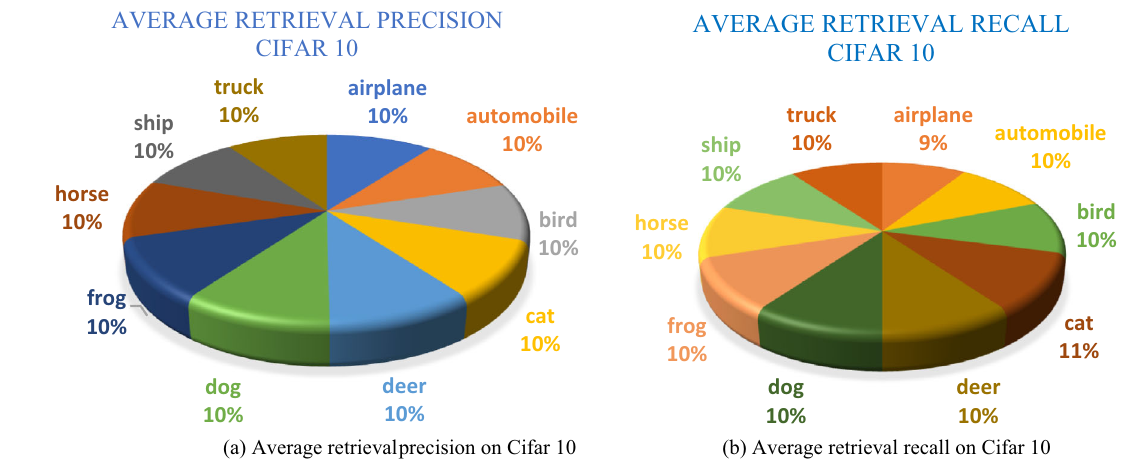
Fig. 5 a Average retrieval precision on Cifar 10. b Average retrieval recall on Cifar 10